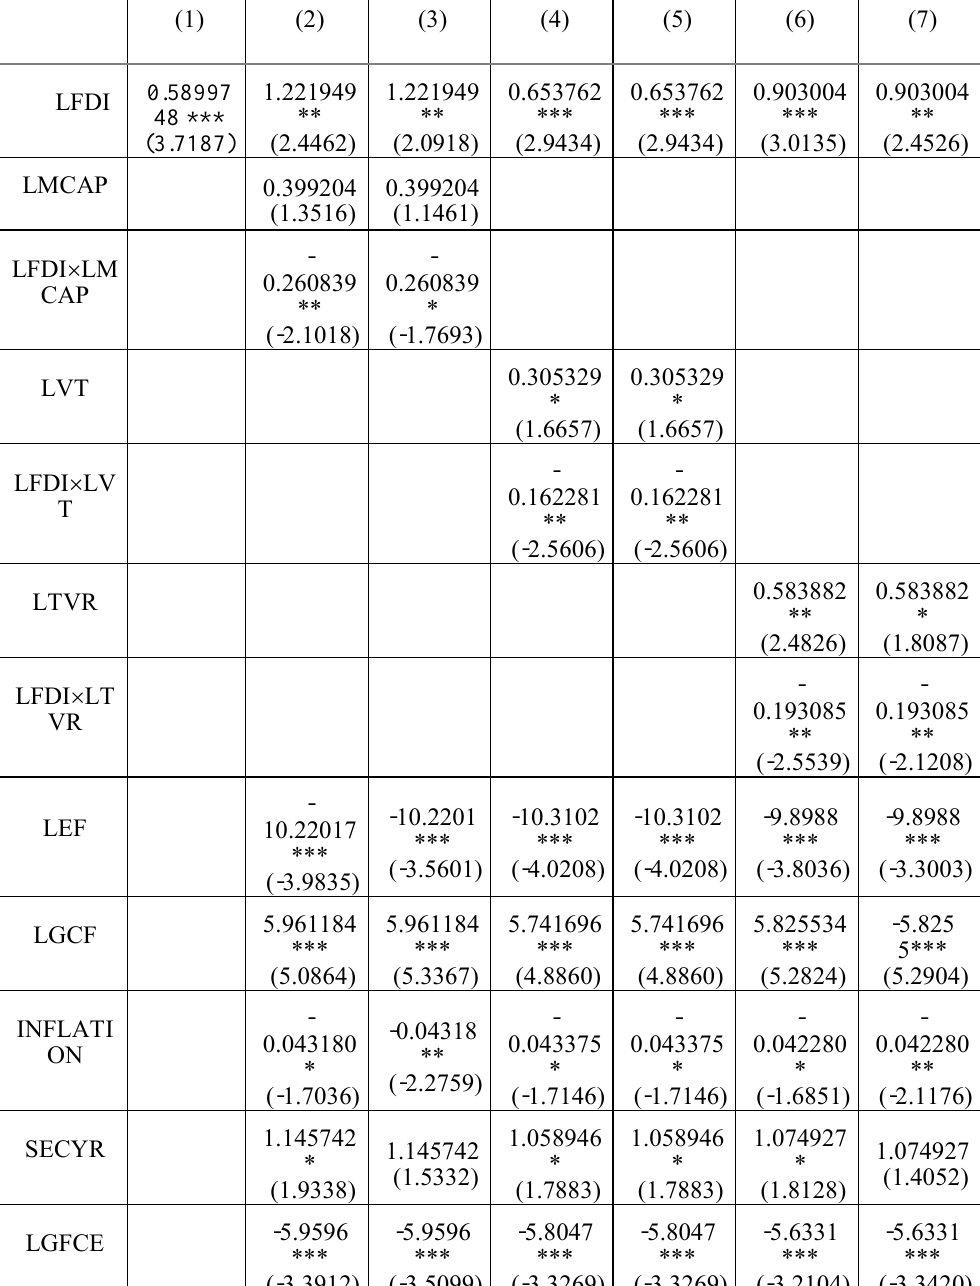
Table8. the effect of stock market development (regression of equation